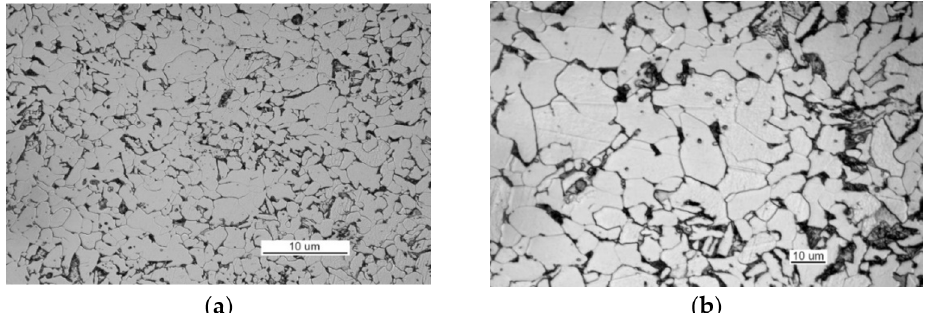
Figure 32. Optical microscopy views (handy-size bulk carrier 30210 DWT): ( a ) the ferritic and pearlitic structure of the material in part 1 and ( b ) the ferritic and pearlitic structure of the material, with visible non-continuous cementite network at the ferrite grain boundaries.